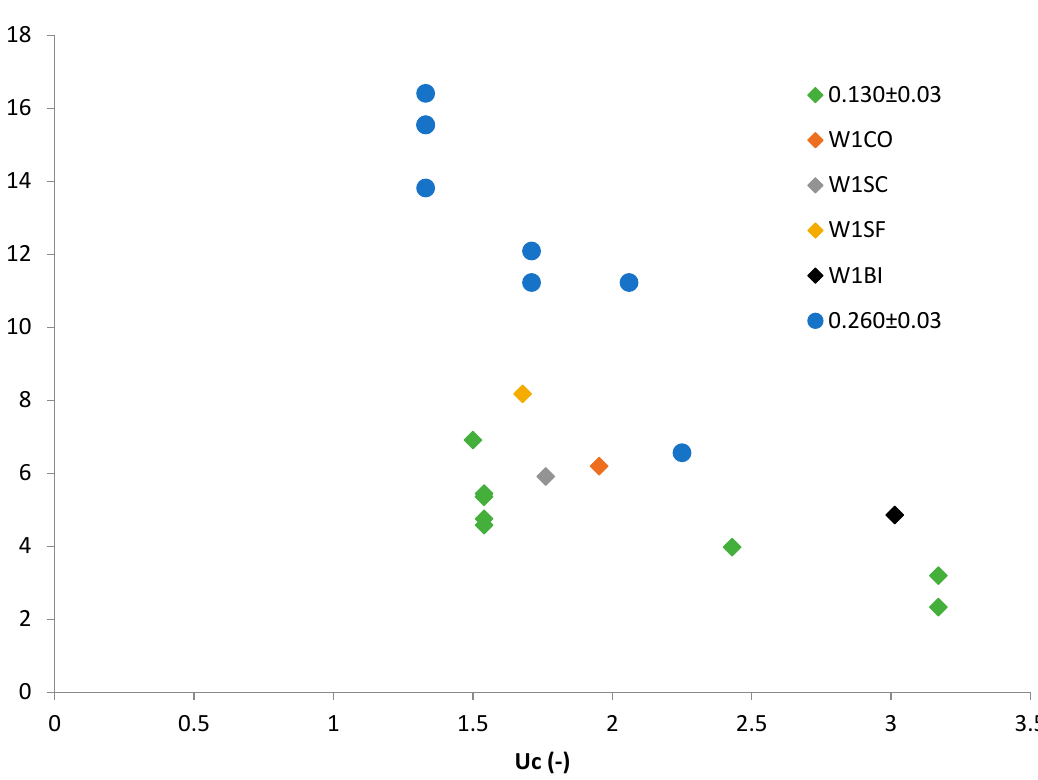
Table 3. Confidence intervals for the fitted values of Equation